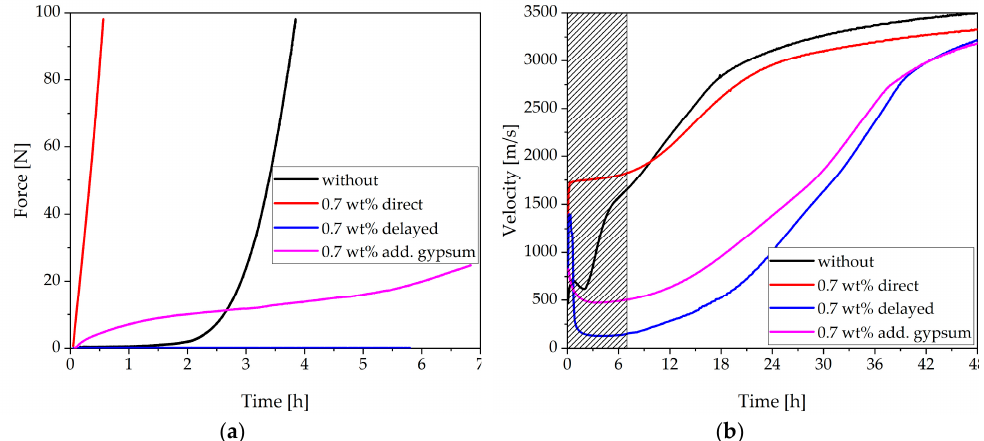
Figure 7. Comparison of the rheological behavior of a sample without SP, with 0.7 wt% of SP (direct addition), 0.7 wt% of SP (delayed addition), and 0.7 wt% of SP (direct addition), and with an additional amount of 2 wt% of gypsum measured with ( a ) a penetration test (MILD), ( b ) ultrasound velocity.